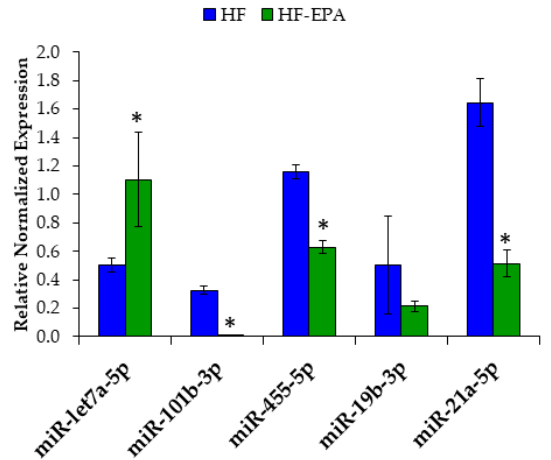
Figure 8. Eicosapentaenoic acid (EPA) supplementation significantly alters miRNA liver expression. miR-let7a-5p was significantly increased in the high-fat (HF)-EPA group; miR-101b-3p, -455-5p, and -21a-5p were significantly decreased with EPA; miR-19b-3p was significantly decreased in profiling but could not be validated. Data are expressed as mean ± SEM, n = 4–6, * = p < 0.05.